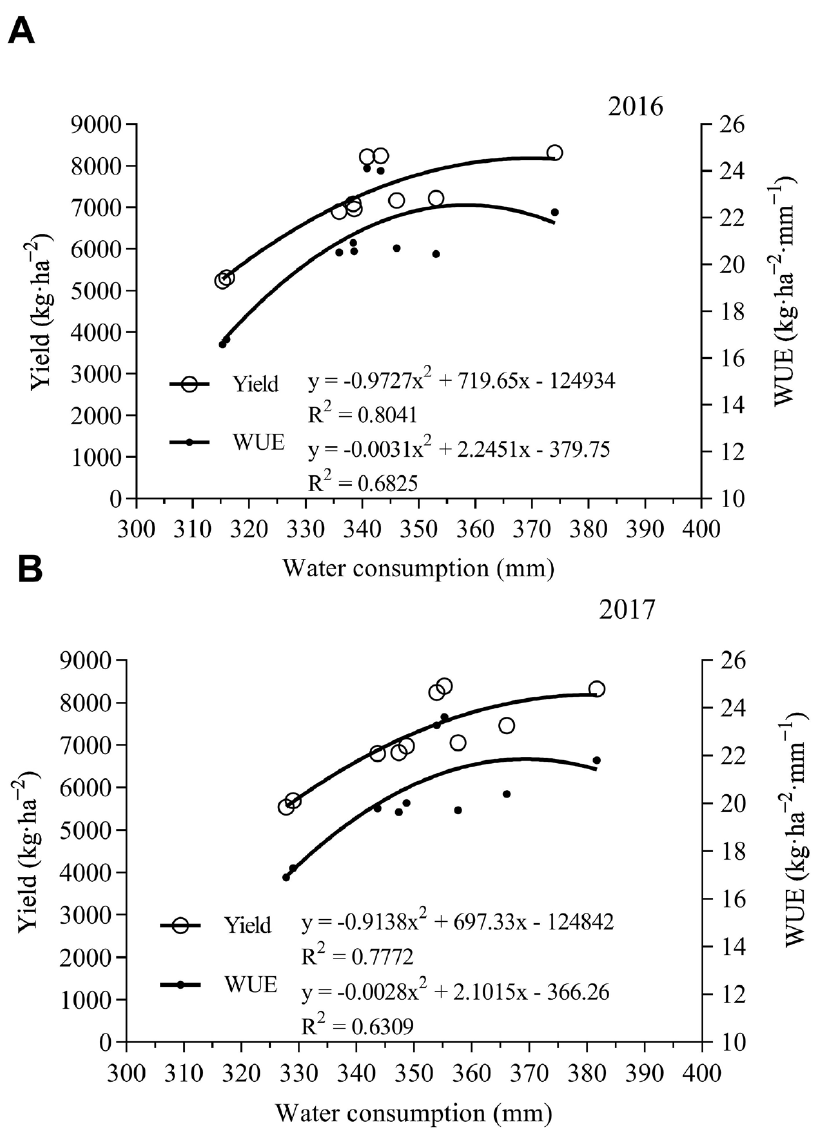
Figure 5. Relationship between yield and water-use efficiency ( WUE ) and water consumption. Different lowercase letters within a column indicate a significant difference among treatments at p < 0.05. ( A ) The experimental data in 2016. ( B ) The experimental data in 2017.